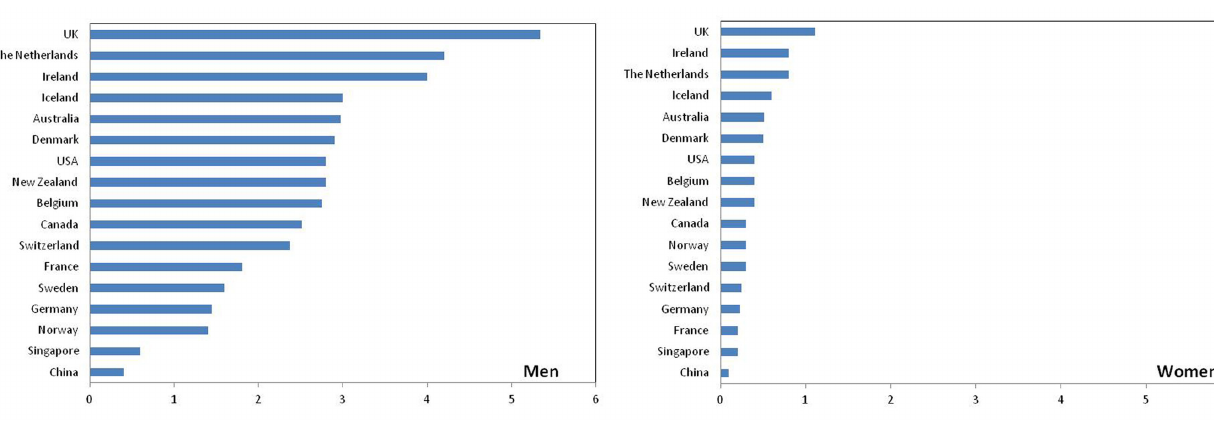
Frontiers in Oncology | Cancer Epidemiology and